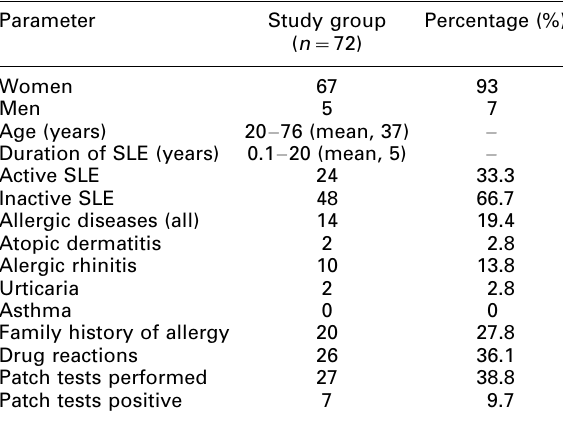
Table 1. The SLE patients’ characteristics